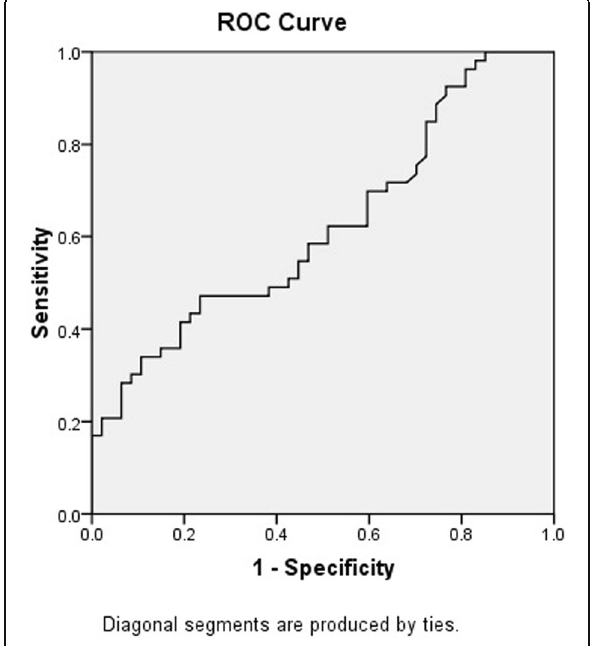
Fig. 7 Receiver operating characteristic (ROC) curve for detection of sensitivity and specificity of Delta MPV at day 2